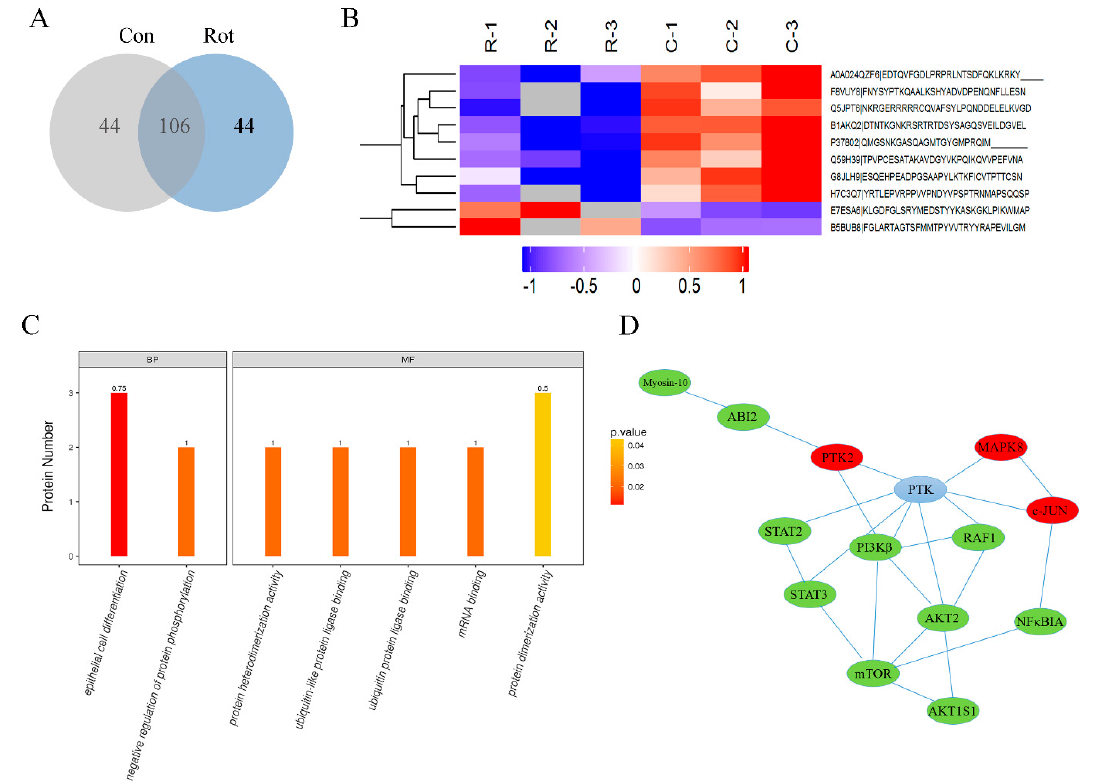
Figure 3. Proteomic profiling of phosphorylation in rotenone-injured SH-SY5Y cells. SH-SY5Y cells were incubated with or without 100 μ M of rotenone for 30 min and then harvested for PTMScan multipathway analysis. ( A ) Venn diagram to show the number of overlapping phosphopeptide identifications between the rotenone group (Rot) and control group (Con). ( B ) Hierarchical cluster of phosphopeptides differentially expressed between the rotenone group and control group. Each row represents a different phosphopeptide. Each column represents a different treatment, as indicated. C-1, C-2, and C-3 represent three replicates for the control group. R-1, R-2, and R-3 represent three replicates for the rotenone group. Red means an increase in abundance relative to the control. Blue means a decrease in abundance relative to the control. ( C ) Gene ontology (GO) enrichment analyses of phosphorylated proteins. The proteins were classified as biological processes (BPs) and molecular functions (MFs). ( D ) Protein–protein interaction (PPI) network analysis of differentially expressed phosphoproteins. Upregulated proteins are highlighted in red, and downregulated proteins are highlighted in green. PTK = protein tyrosine kinase, PTK2 = focal adhesion kinase 1, ABI2 = Abl interactor 2, MAPK8 = mitogen-activated protein kinase 8, RAF1 = RAF proto-oncogene serine/threonine-protein kinase, PI3K β = phosphatidylinositol-4,5-bisphosphate 3-kinase catalytic subunit beta isoform, NF κ BIA = NF-kappa-B inhibitor alpha, Akt = RAC-beta serine/threonine-protein kinase, mTOR = mammalian target of rapamycin, STAT2/3 = signal transducer and activator of transcription 2/3, Akt1S1 = Akt1 substrate 1.